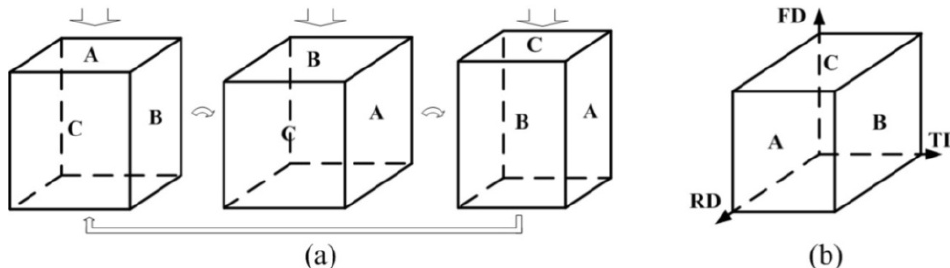
Figure 1. Schematic drawings of ( a ) the high strain rate multiple forging (HSRMF) process; ( b ) axis definition of the alloys as  Δε =